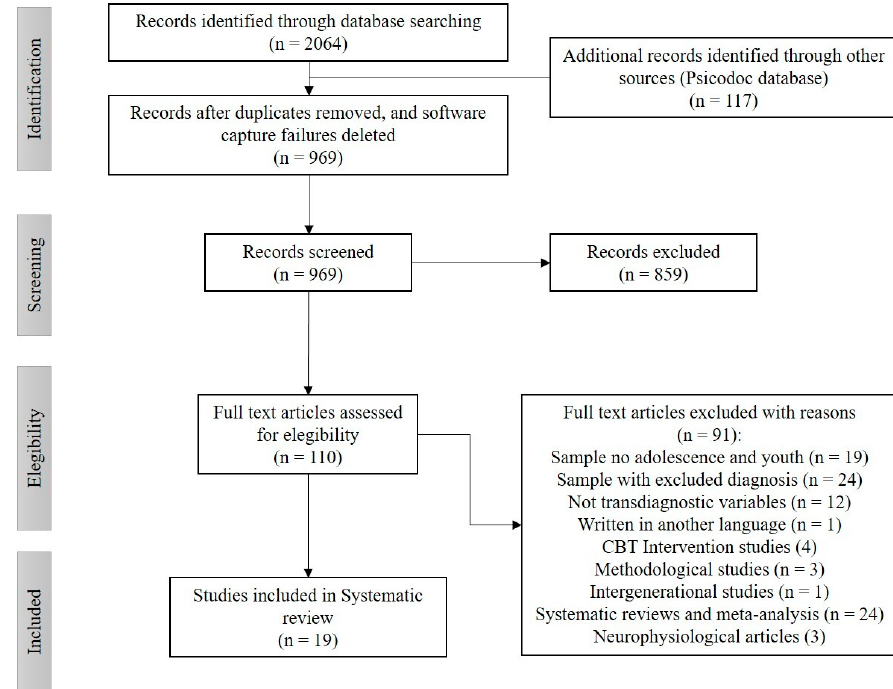
Figure 1. PRISMA model of systematic review study identification and inclusion.